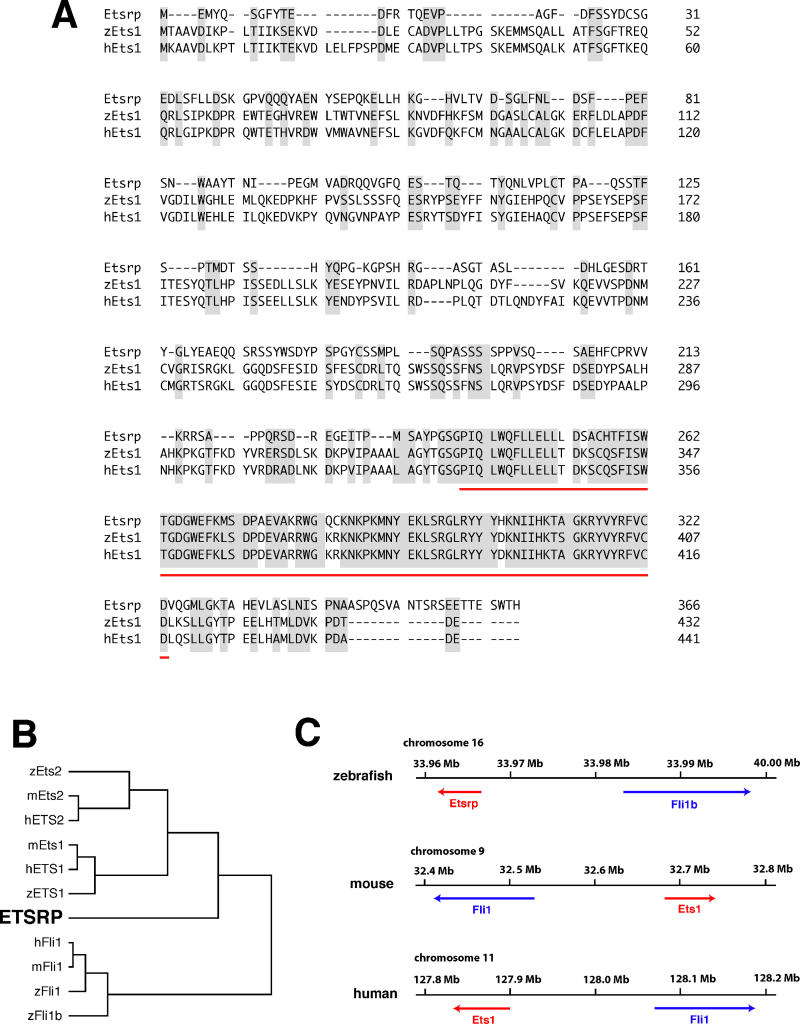
Sequence Analysis of the Zebrafish Ets1-Related Protein Etsrp(A) Shows alignment of Etsrp and its closest human and zebrafish homologs Ets1 proteins. Etsrp and hEts1 share 88% homology within the ETS DNA-binding domain (underlined in red), and a very limited homology within the rest of the sequence. Identical and similar amino acids are shaded in grey. (B) The homology tree of Etsrp and its closest human, mouse, and zebrafish homologs. Length of horizontal branches is directly proportional to the evolutionary distance between the proteins. Zebrafish Ets1 and Ets2 protein sequences have been predicted using the available EST sequences TC282499 and TC270146 (http://www.tigr.org). GeneWorks 2.5 has been used to build the alignment and the homology tree. (C) Chromosomal location of the zebrafish etsrp, mouse, and human ets1 genes. In all cases, they are positioned next to a fli1 homolog.